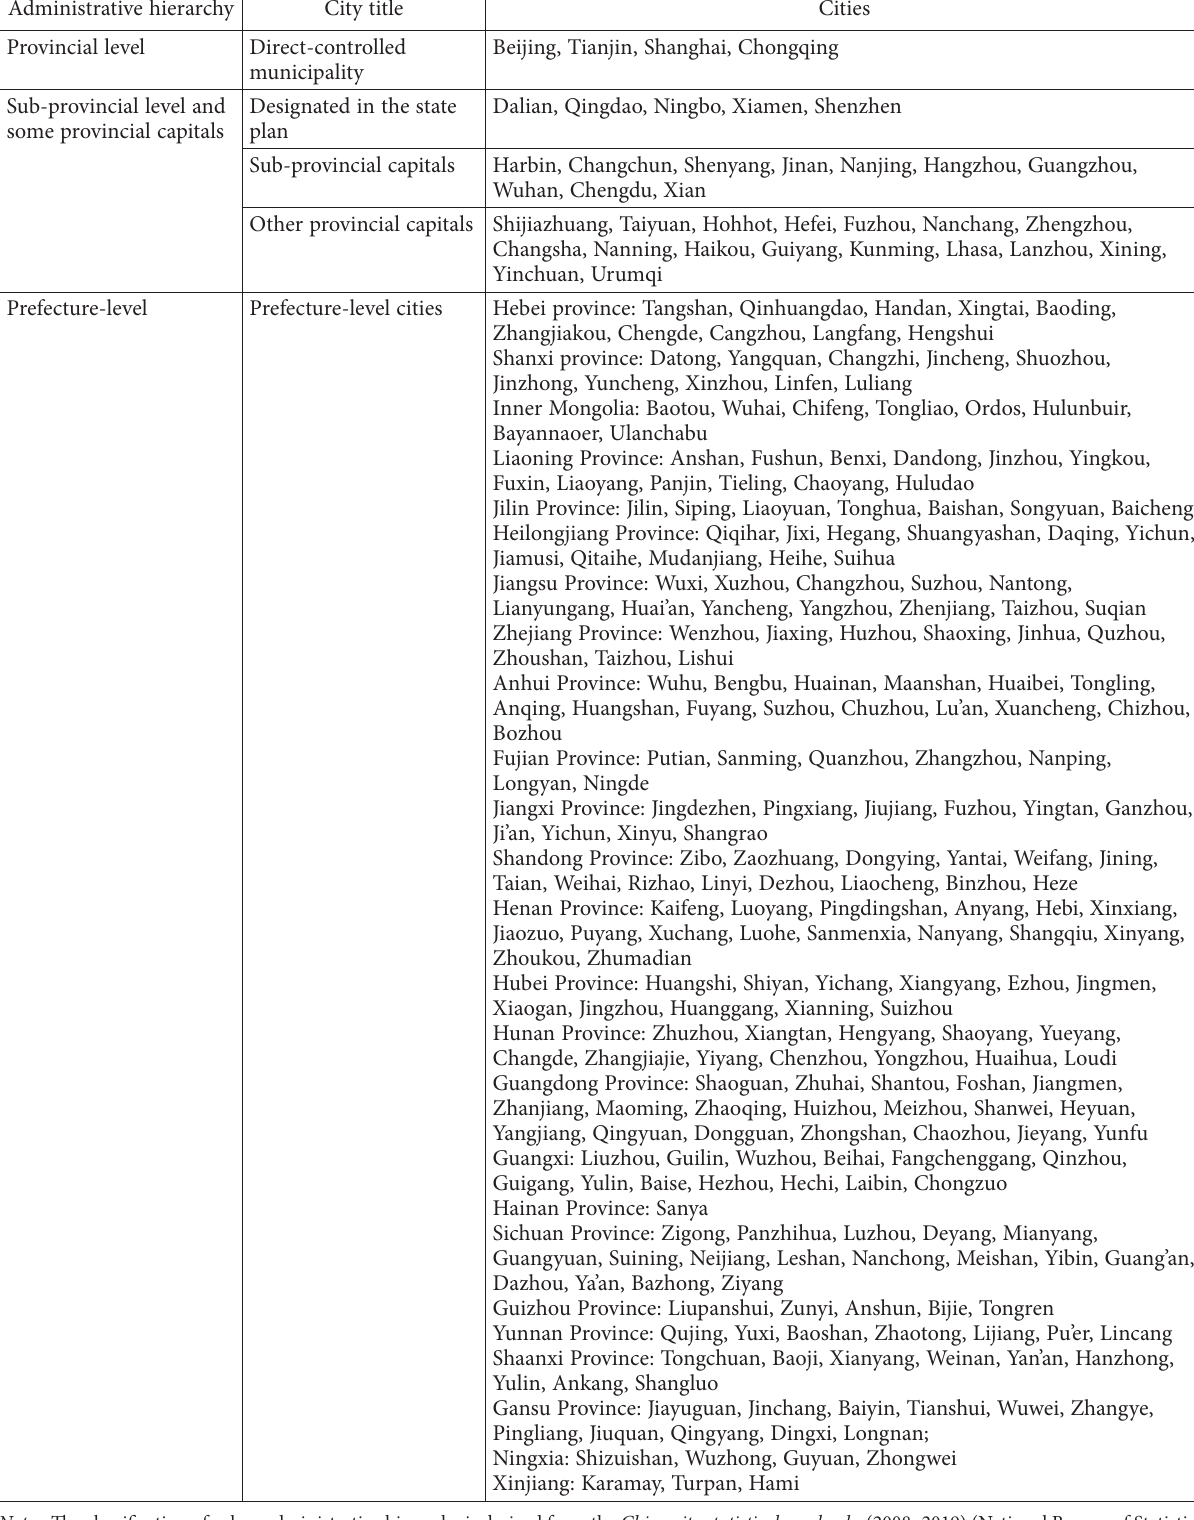
Table A1. The classification of urban administrative